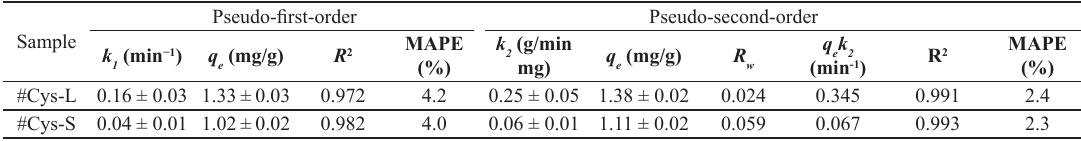
Table 2. Kinetic parameters obtained from the fittings with the PFO and PSO models.